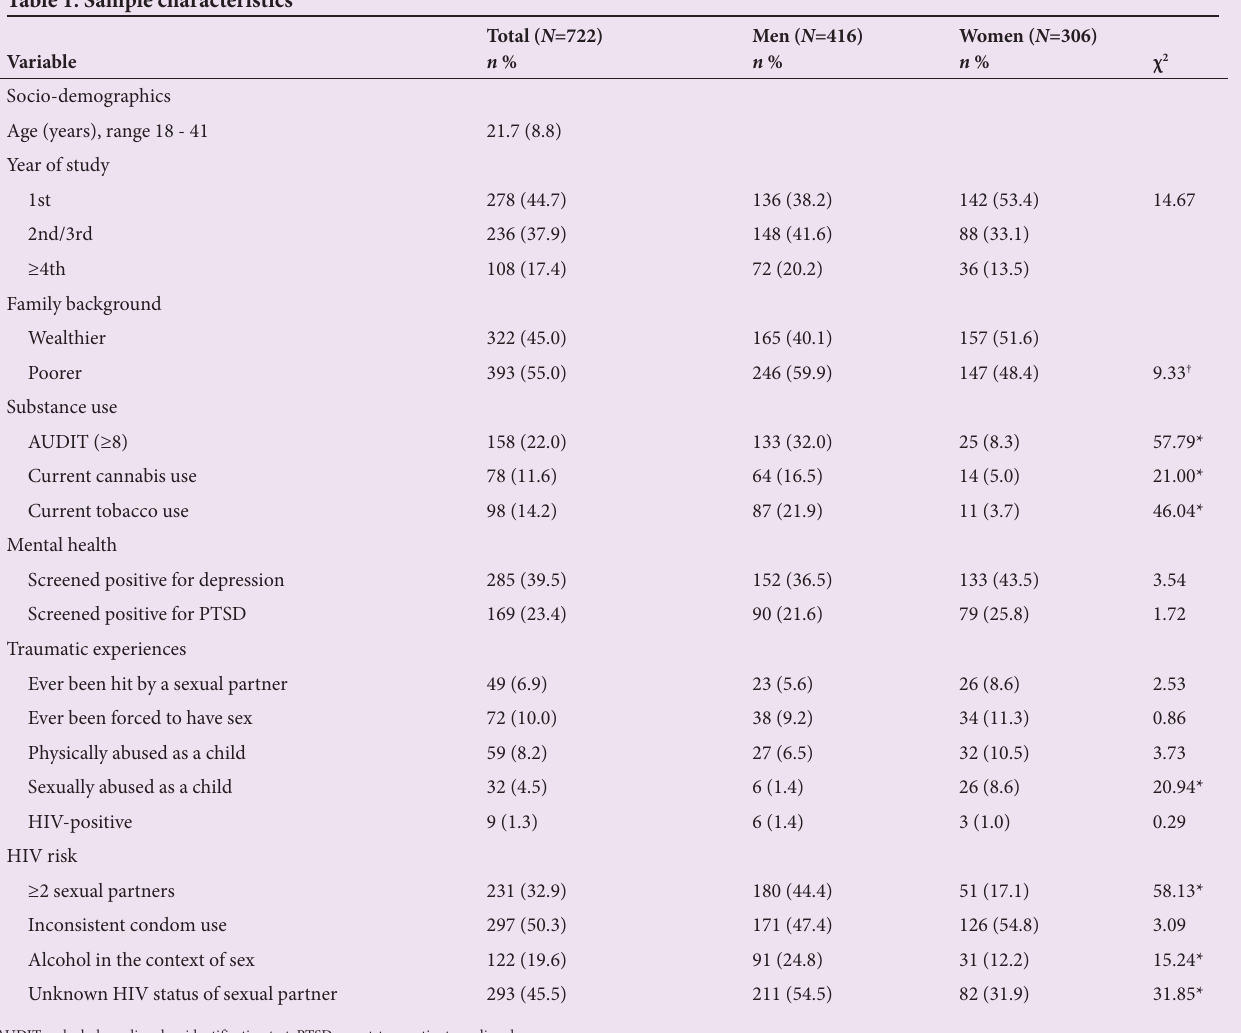
Table 1. Sample characteristics